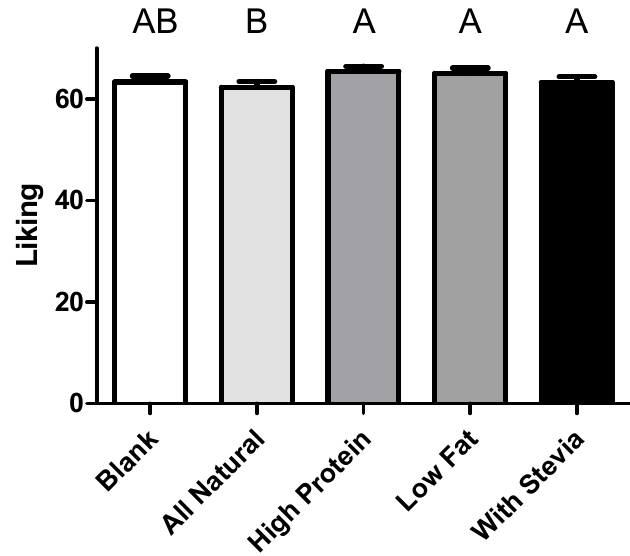
Figure 2. Overall liking of samples rated from 0 to 100 with anchors at 0 (Most imaginable disliking), 16 (Dislike extremely), 27 (Dislike very much), 40 (Dislike moderately), 47 (Dislike slightly), 50 (Neither like nor dislike), 53 (Like slightly), 70 (Like moderately), 73 (Like very much), 83 (Like extremely), and 100 (Most imaginable liking). Letters denote significant differences. Bars denote mean plus standard error.